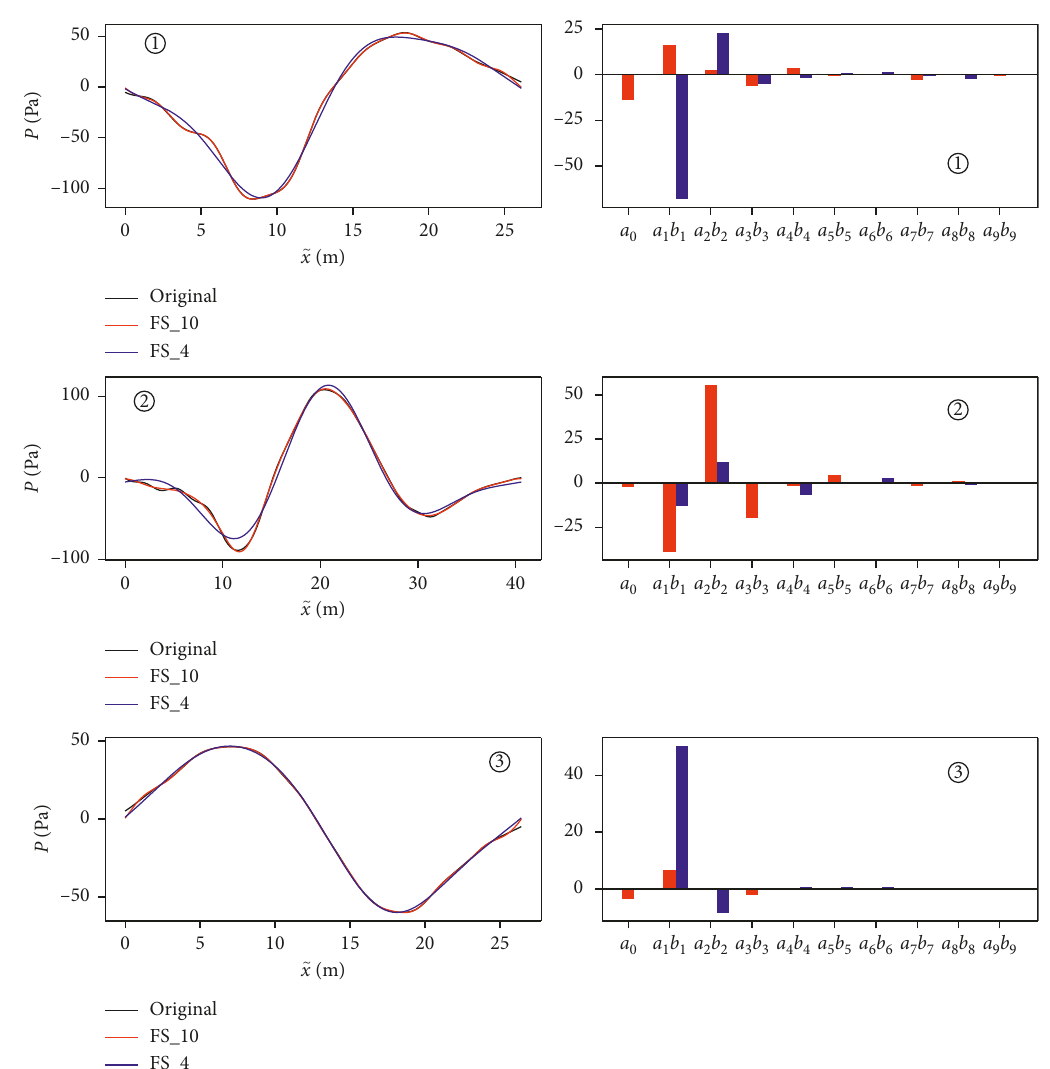
Figure 10: Distributed forces transformed from the pressure signal in Figure 8 and its Fourier series representations (FS_10 and FS_4 represent first-10 and first-4 Fourier series representations,